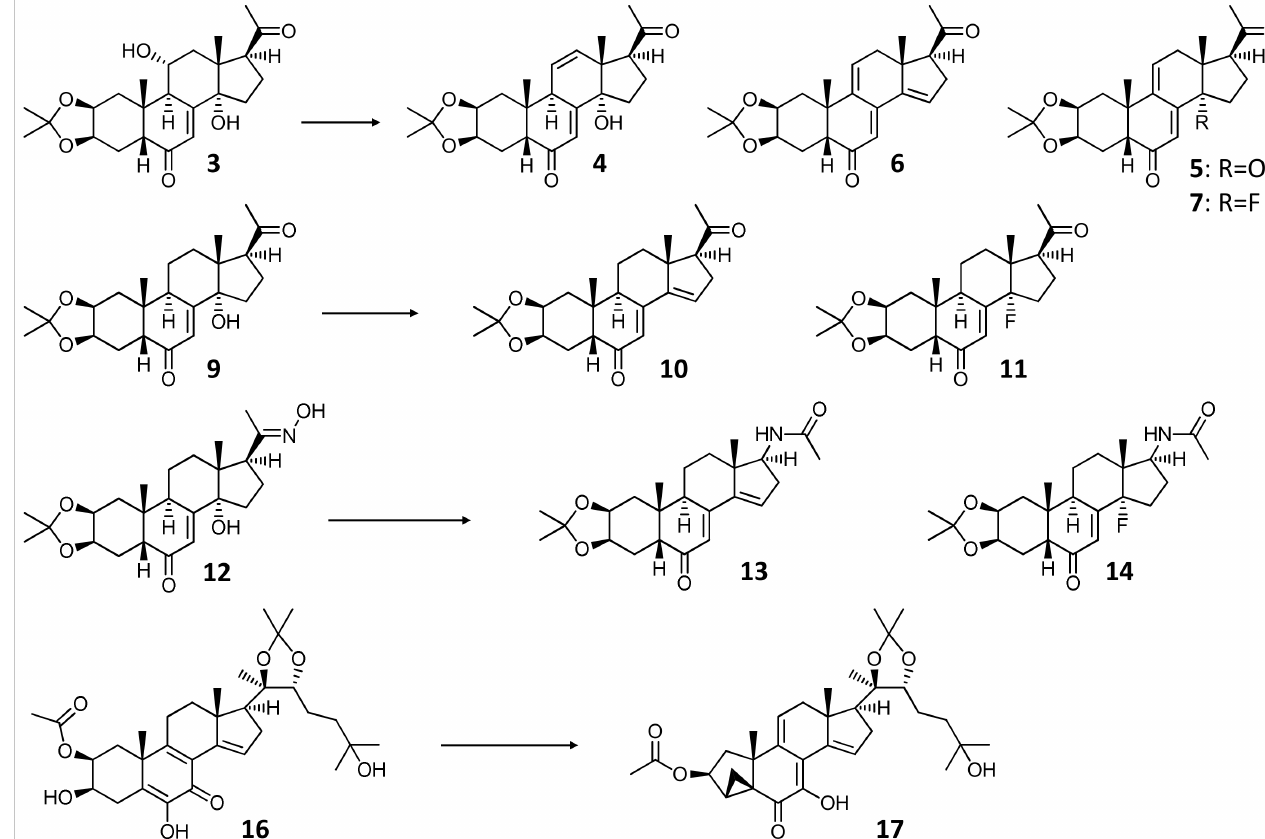
Figure 4. Structures of products obtained by the DAST-mediated transformation of compounds 3 , 9 , 12 , and 16 . Reagents and conditions: DAST, anh. CH 2 Cl 2 , − 84 ◦ C → room temperature, 70